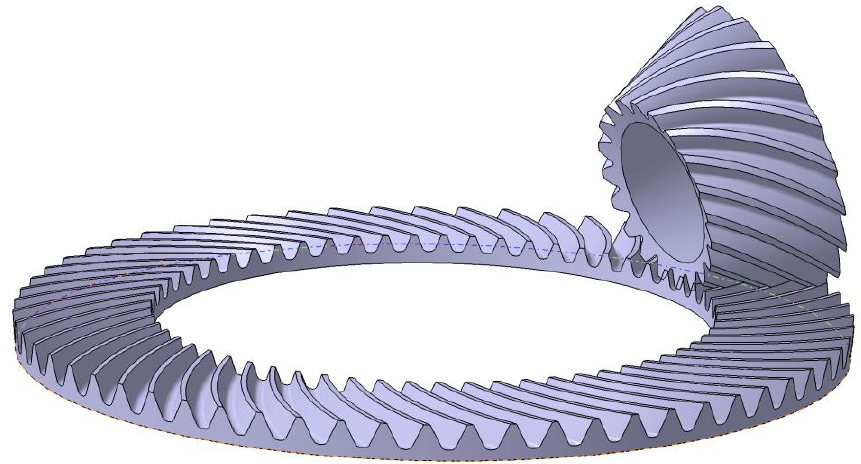
Figure 9. 3D model of